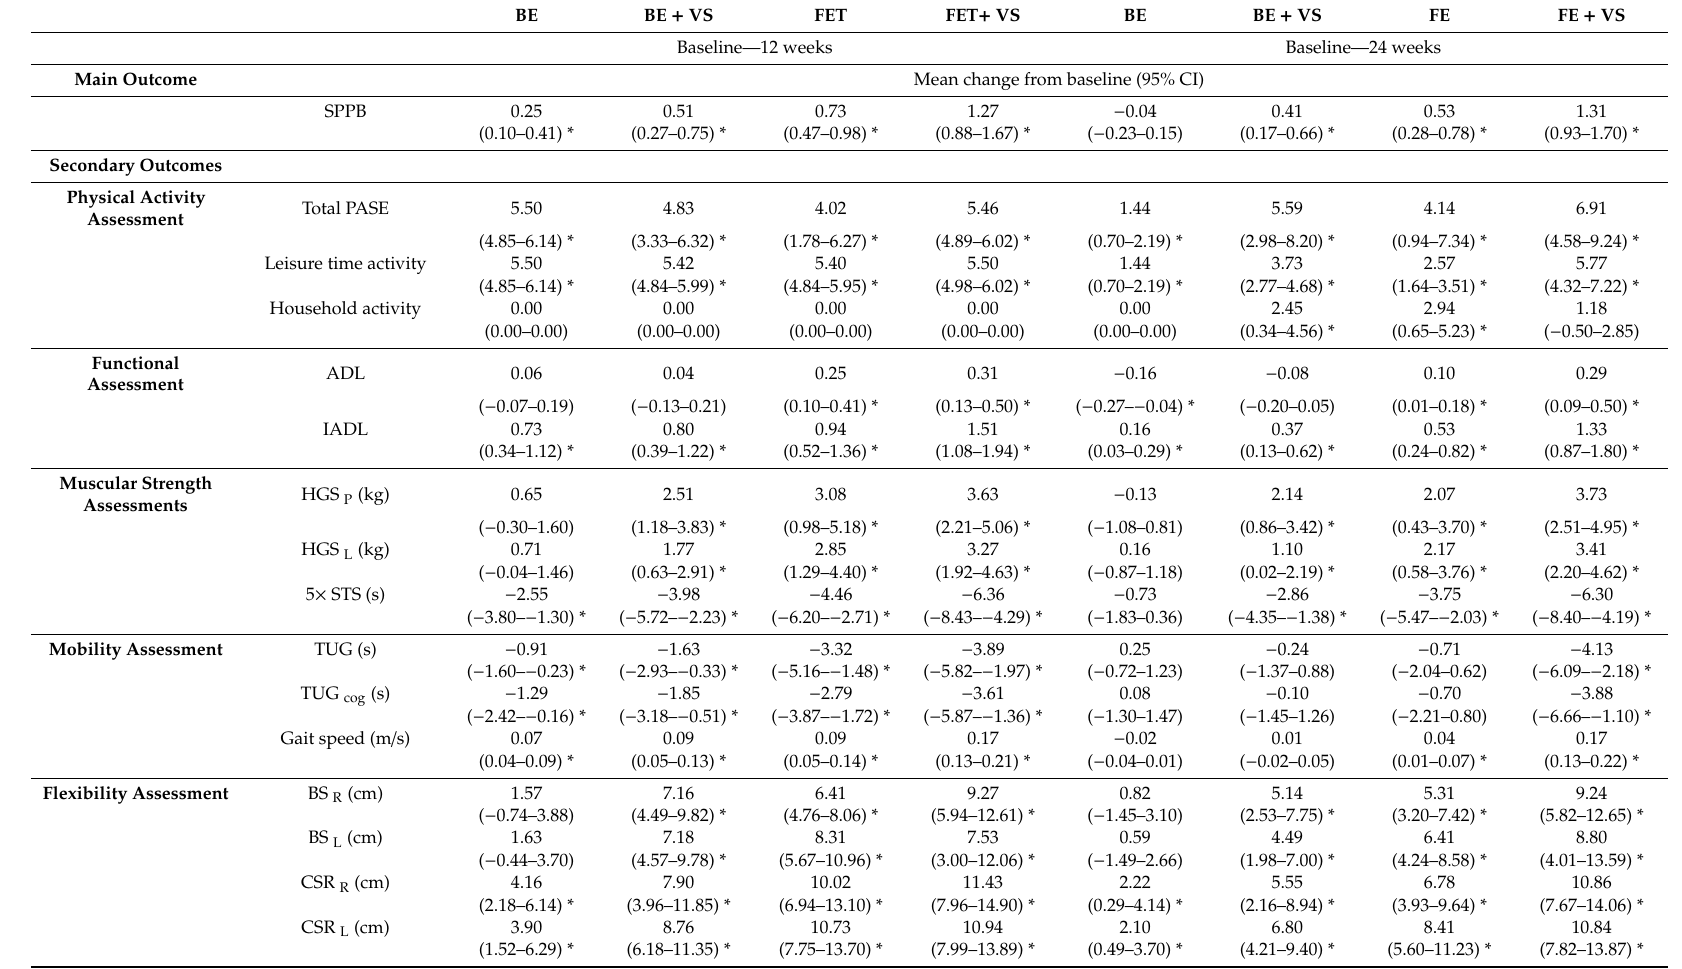
Table 2. Mean di ff erence scores for each group across